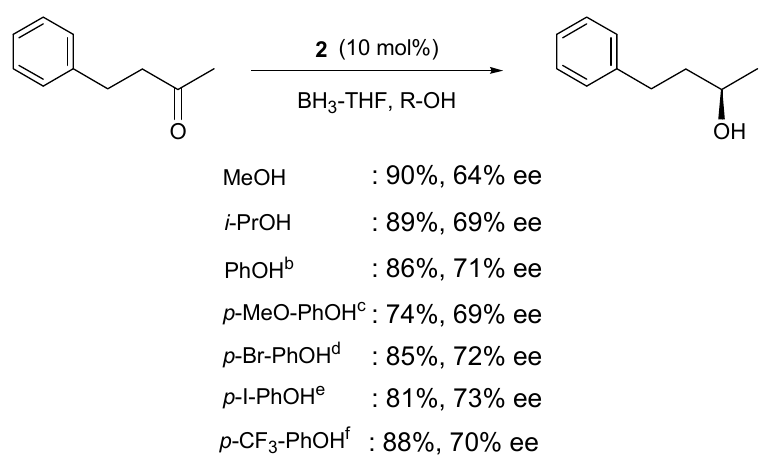
Figure 3. Various chiral catalysts and precatalysts.